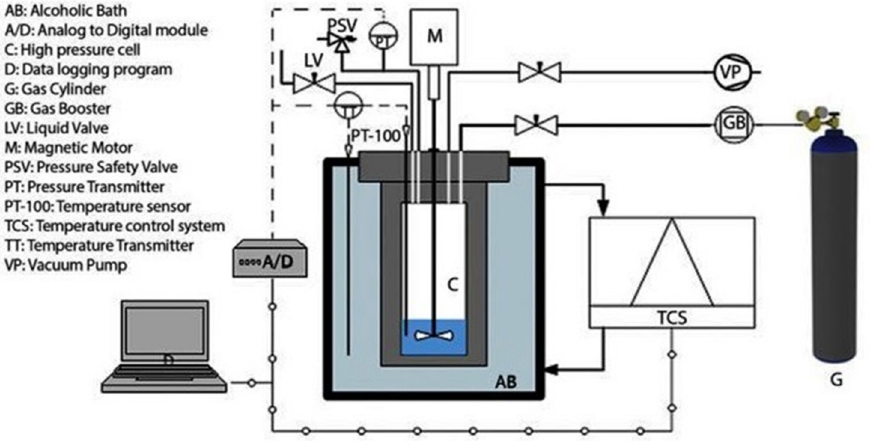
Figure 2. Experimental setup